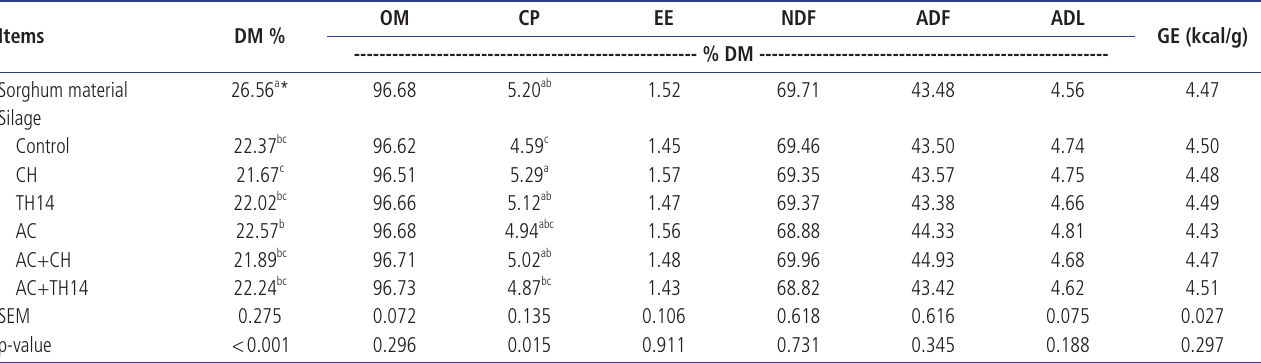
Table 2. Chemical composition, LBC, WSC, and GE of sorghum material prior to ensiling and its silages at 30 days after fermentation Items